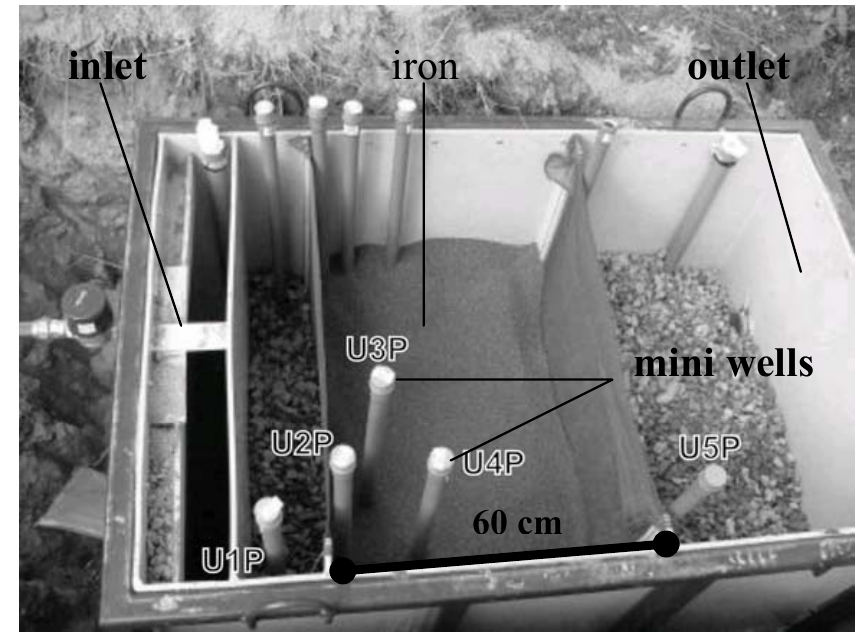
Fig. 2 Construction of the box with reactive